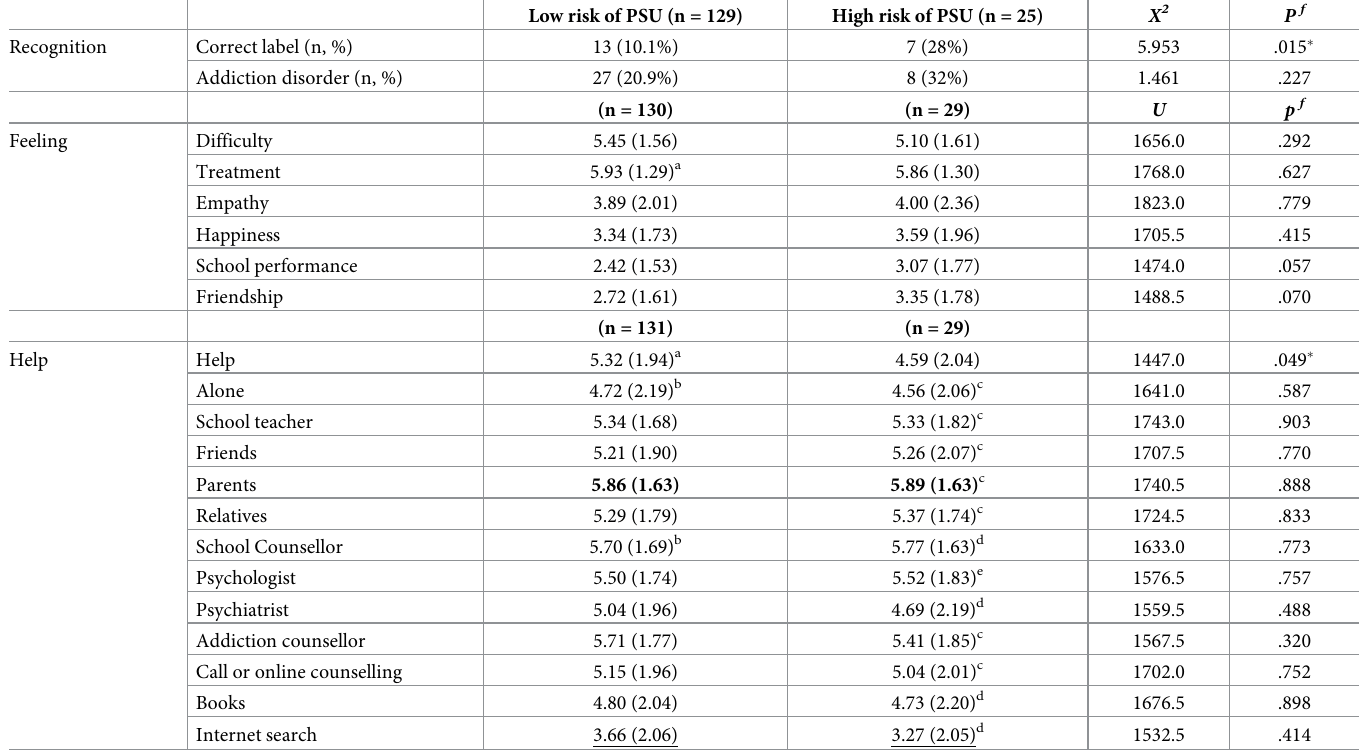
Table 5. Comparison between participants with the low and high risk of